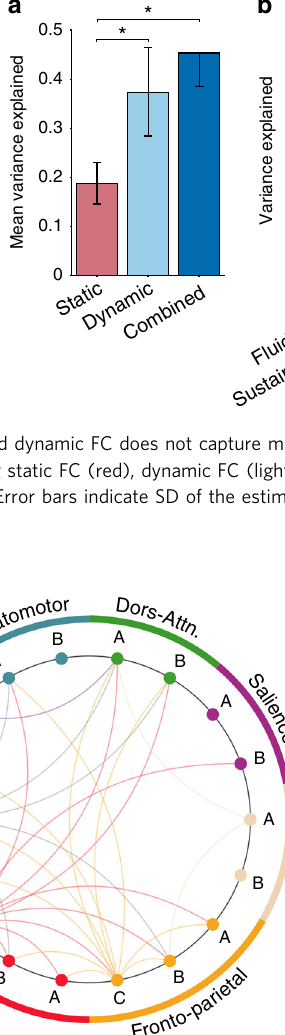
Fig. 5 Dynamic FC interactions contributing the most to the association with task-performance. Networks and corresponding colors are the same as in Fig. 3, and subnetworks are de fi ned following the 17-network parcellation of Schaefer et al. 35 , as reported in Supplementary Fig. 4. The colors of the edges are de fi ned by their destination and only connections surviving an FDR correction at the level q = 0.05 are a covariate in the variance component model, (ii) evaluating the static and dynamic FC matrices from fMRI time series from which the mean cortical grayordinate signal was not regressed, (iii) including head motion metrics as covariates in the variance component model, (iv) evaluating the static and dynamic FC matrices from full (i.e., uncensored) fMRI time series, (v) the number of behavioral measures considered in the variance component model, and (vi) the relative contributions of static and dynamic FC to the overall variance explained within the com- bined variance component model. The variance component model appeared to be robust to these changes and in each case, our main fi ndings were reproduced (Supplementary Figs. 10 – 12).